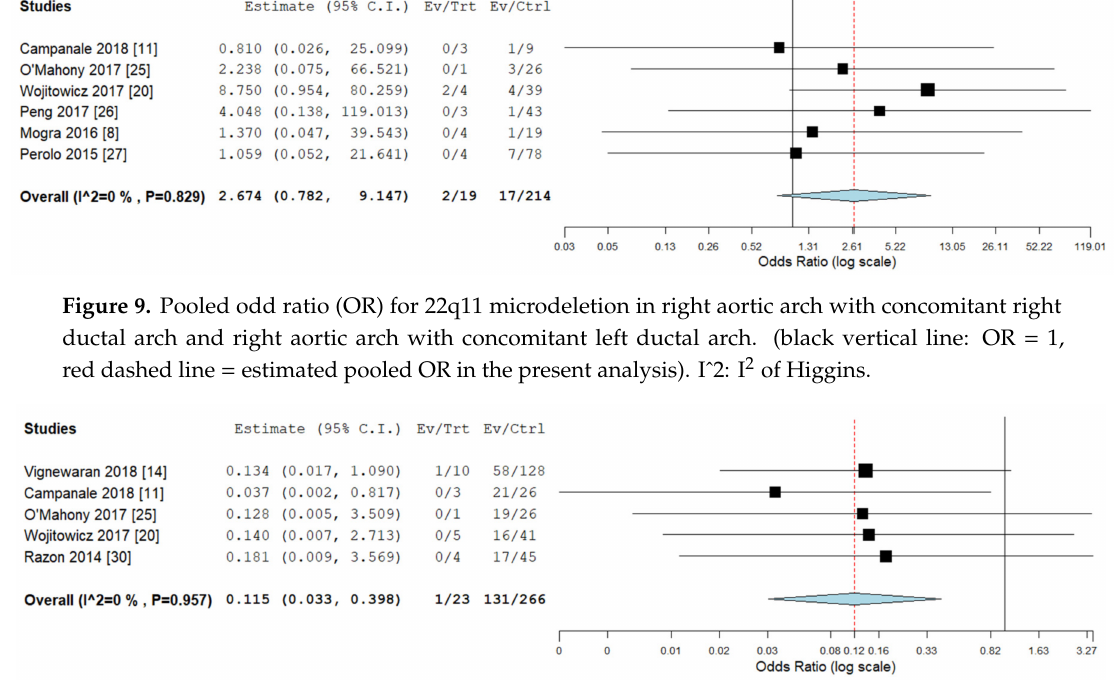
Figure 10. Pooled odd ratio (OR) for aberrant left subclavian artery in right aortic arch with concomitant right ductal arch and right aortic arch with concomitant left ductal arch. (black vertical line: OR = 1, red dashed line = estimated pooled OR in the present analysis). Iˆ2: I 2 of